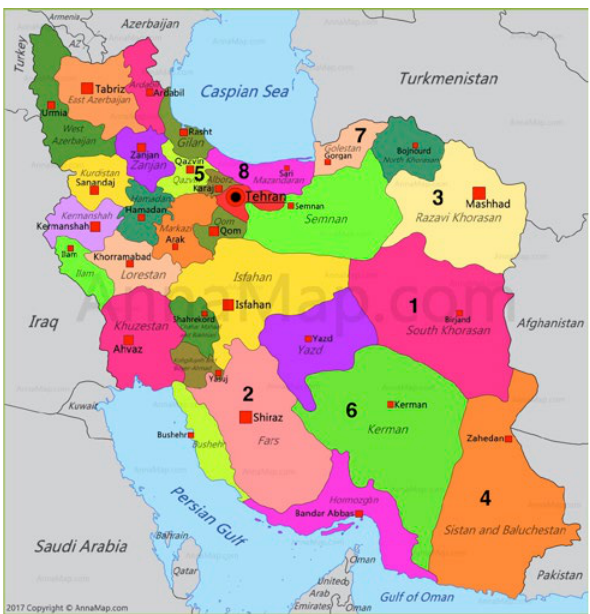
Figure 1. Distribution map of Zizphus jujube populations